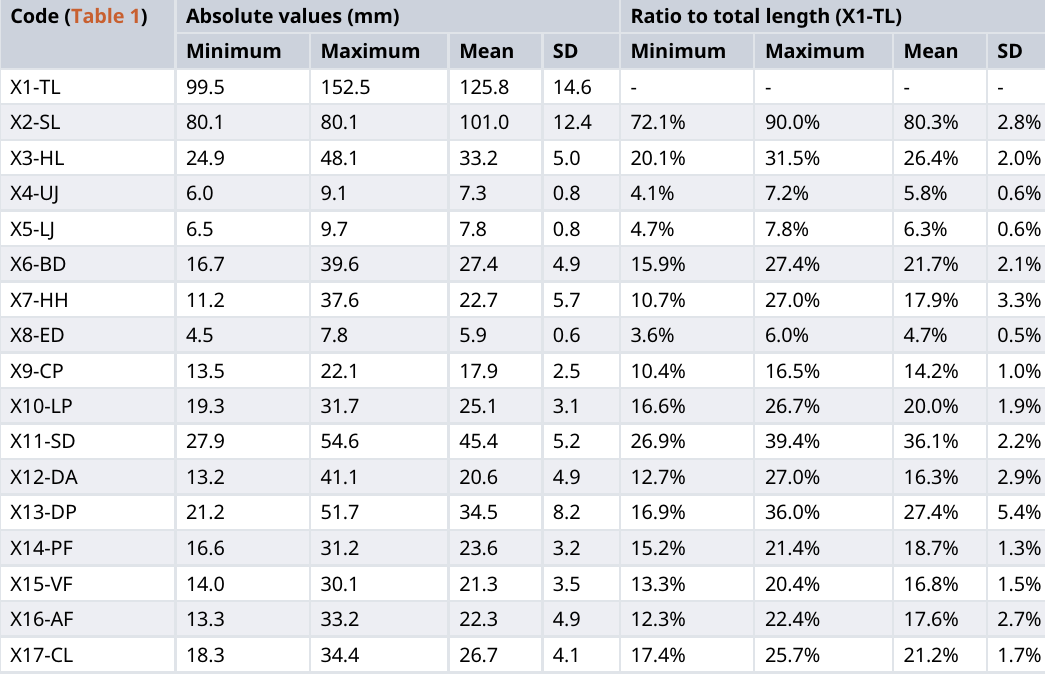
Table 3. Bolano Sau Lake payangka (n=42) morphometric characters. Code (Table